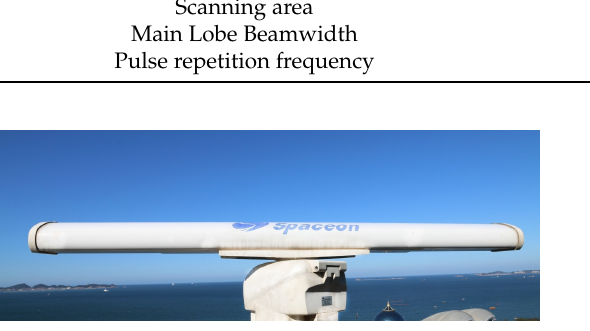
Figure 9. Radar antenna of the real